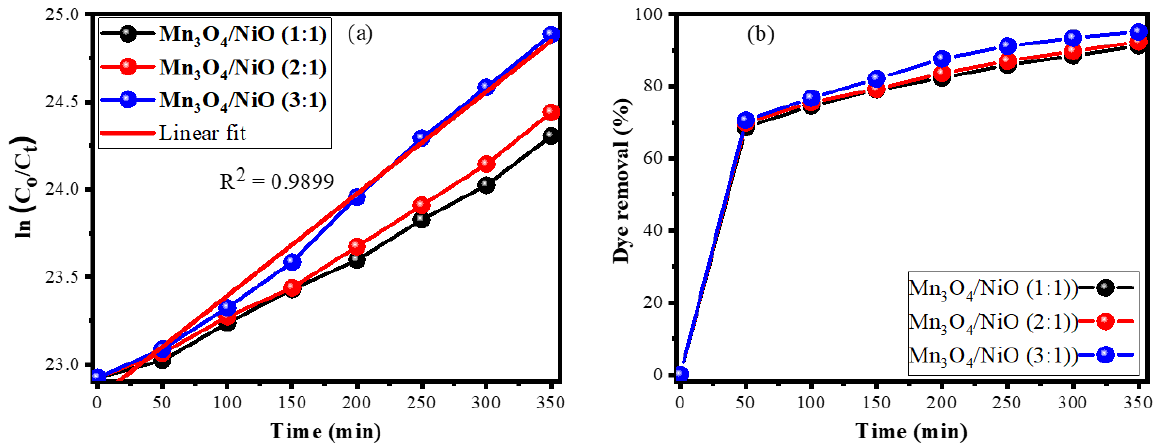
Figure 9. ( a ) Kinetic study of the photocatalytic process for the Mn 3 O 4 /NiO nanocomposites, and ( b ) dye removal percentage at different time intervals.